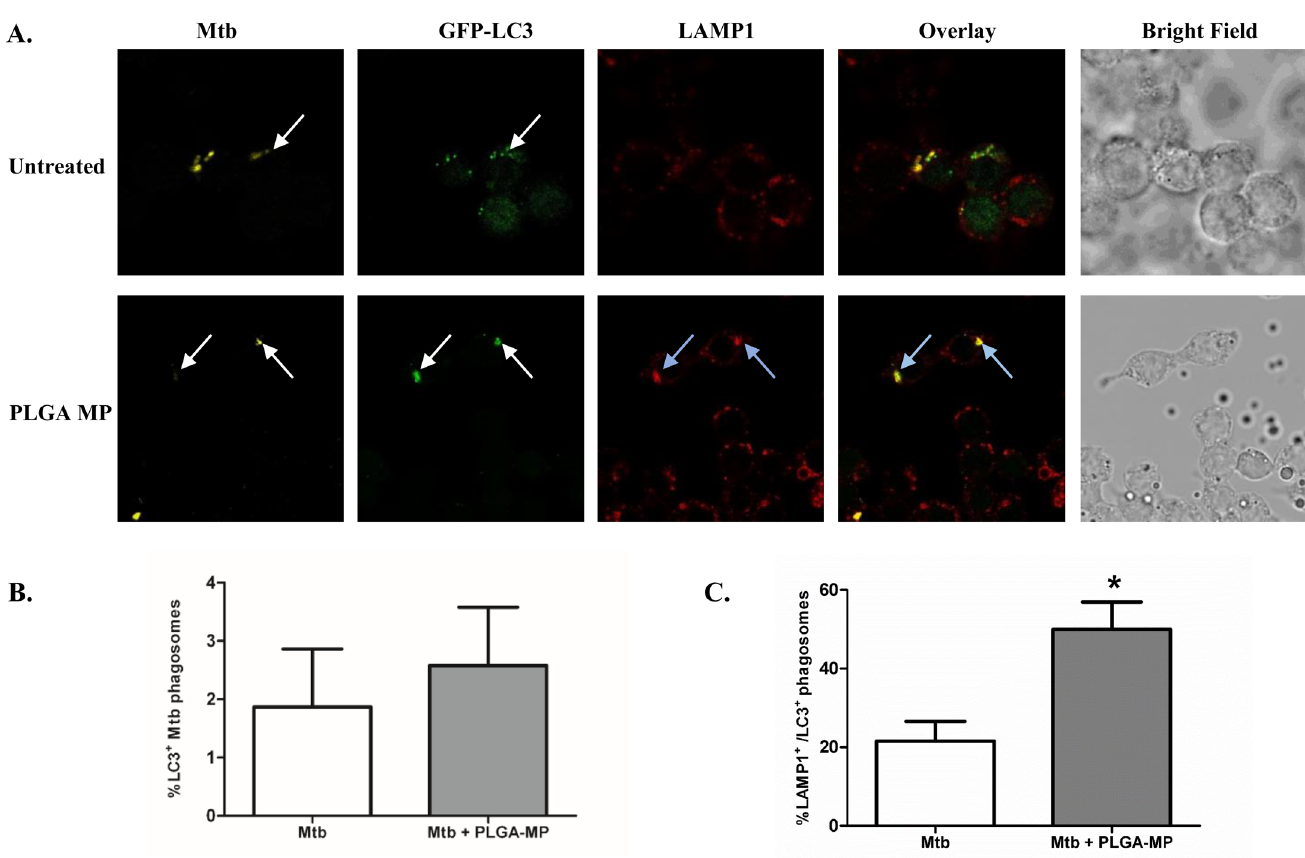
Fig 6. PLGA MPs trigger autophagic flux in Mtb-infected macrophages. Immortalized murine BMDMs expressing GFP-LC3 were infected with Mtb H37Ra at an MOI of 1 – 5 phagocytosed bacilli per cell followed by treatment with PLGA MP as before. (A) After a total of 24 hours, infected macrophages were fixed and stained with anti-LAMP1_and anti-Mtb antibodies, and then observed by laser scanning confocal microscopy. The proportion of (B) LC3 positive Mtb phagosomes and (C) LC3 positive phagosomes which were also positive for LAMP1 were counted. Data represent the mean +/- SEM of three independent experiments in which more than 100 phagosomes were counted for each condition. * P < 0.05. The white arrows indicate localization of Mtb phagosomes with GFP-LC3, blue arrows indicate co-localization of Mtb, GFP-LC3 and LAMP1. The results shown are the means of three independent experiments.